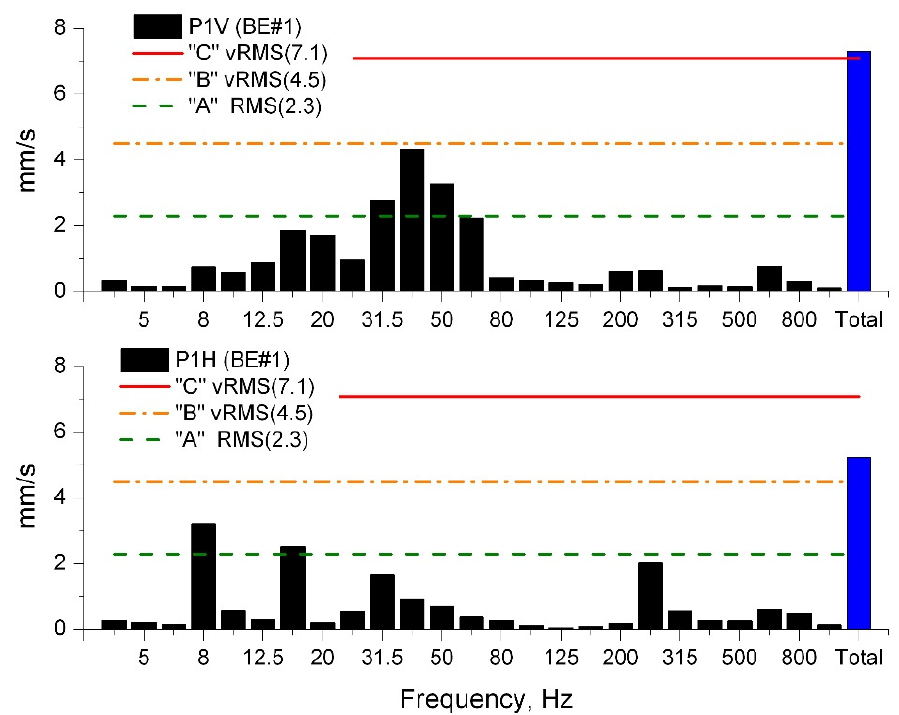
Figure 9. Typical spectrum of the RMS vibration velocity at point P1 in bucket elevator BE#1: in the vertical direction ( top ) and in the horizontal direction ( bottom ). The column with the total value is marked in blue.